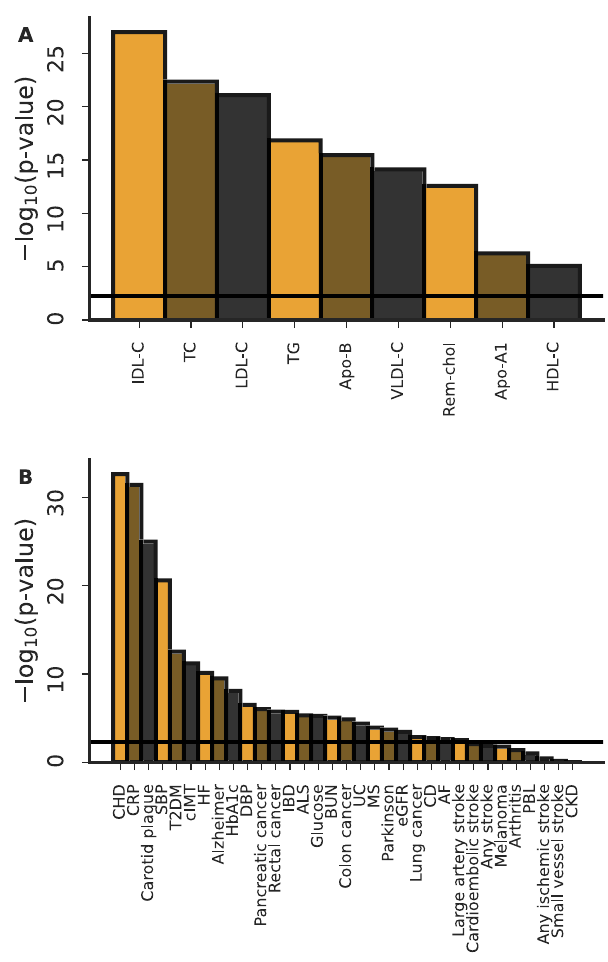
Fig. 6 Kolmogorov-Smirnov overall-null hypothesis tests. Kolmogorov- Smirnov goodness-off- fi t tests were used to compare an empirical p value distribution against the continuous uniform p value distribution expected when the strict null-hypothesis holds. A Here we grouped the empirical p values by exposure and explored whether their distribution agreed with the expected p value distribution when all test would be false-positive. B Here we grouped the empirical p values by outcome and explored whether their distribution agreed with the expected p value distribution when all test would be false-positive. The horizontal lines represent the multiplicity corrected p value threshold, dividing an alpha of 0.05 by the number of exposures or outcomes (the number of